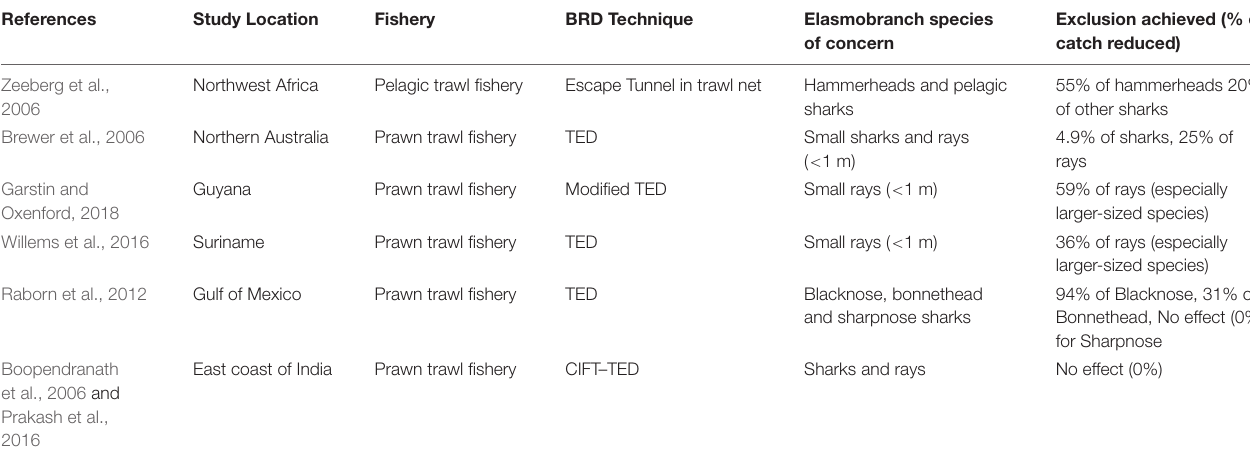
TABLE 5 | Review of bycatch reduction techniques in trawl fisheries for